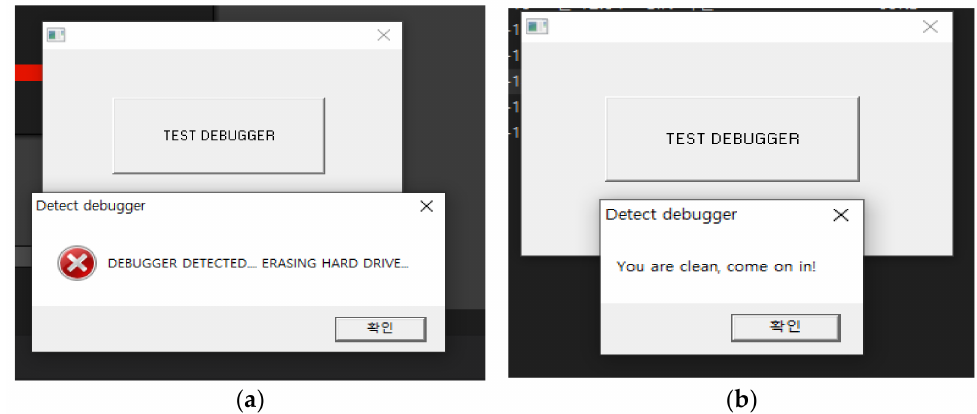
Figure 1. Example of debugger detection. ( a ) Execution of program with anti-debugging applied. ( b ) Execution through IPT.